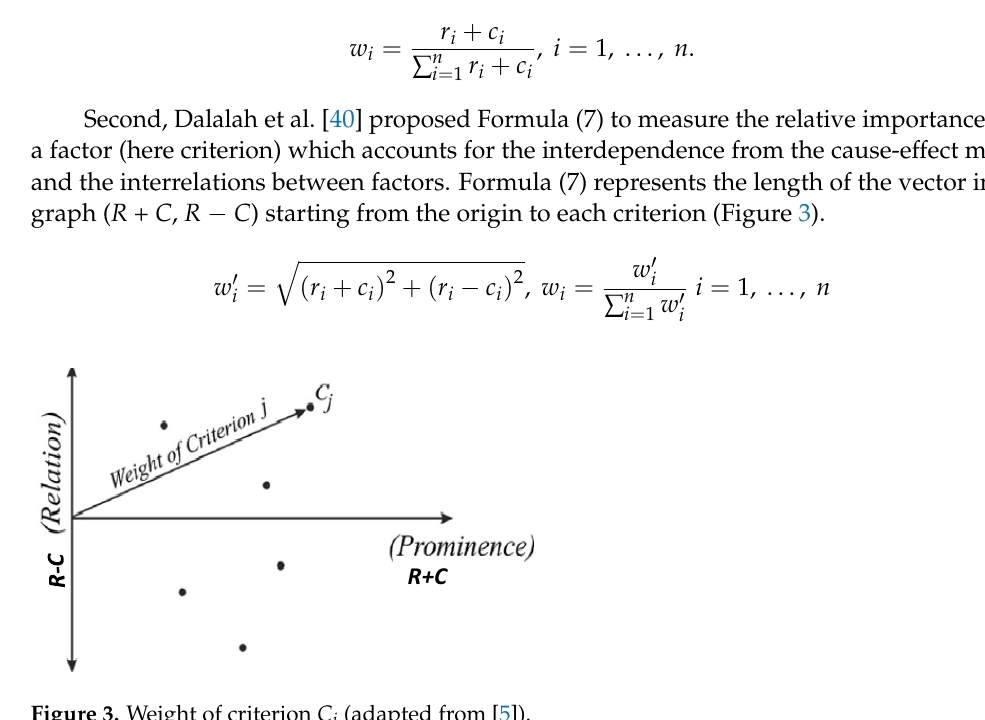
Figure 2. Four-quadrant influential relation matrix, I: Key factors, II: Minor key factors; III: Inde- pendent factors; IV: Indirect factors.